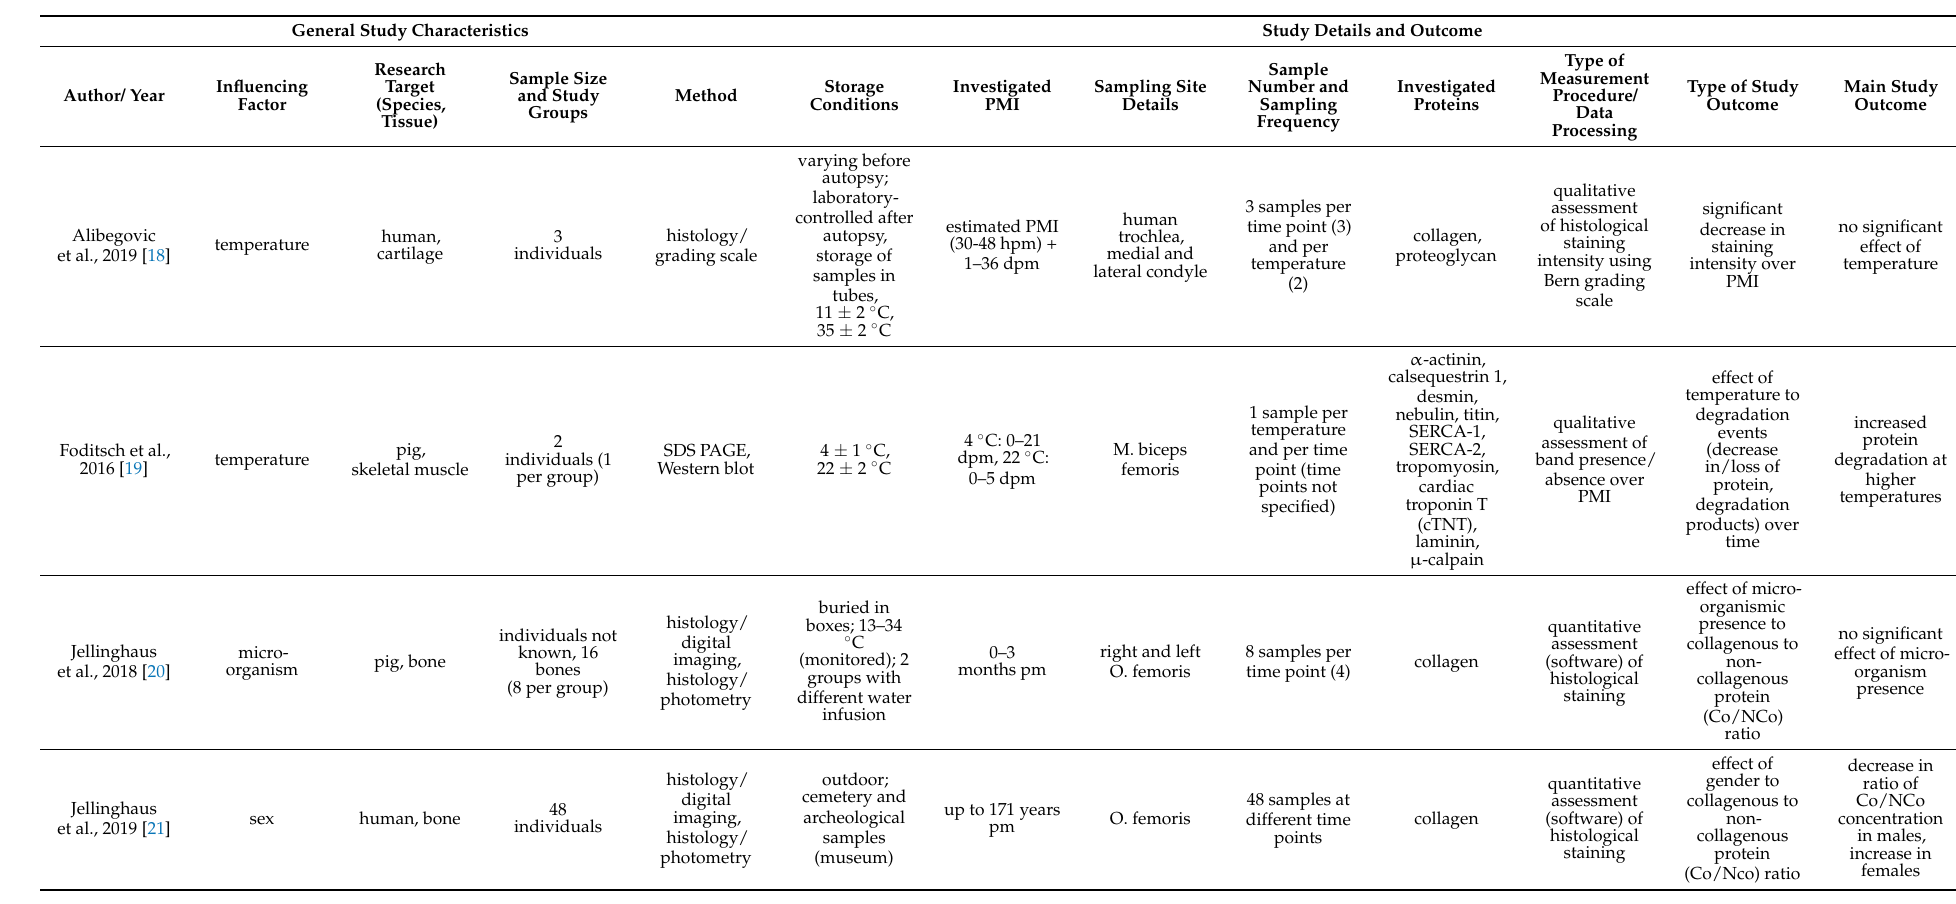
Table 1. Study characteristics, details and main outcomes. PMI, postmortem interval; hpm, hours postmortem; dpm, days postmortem; pm,